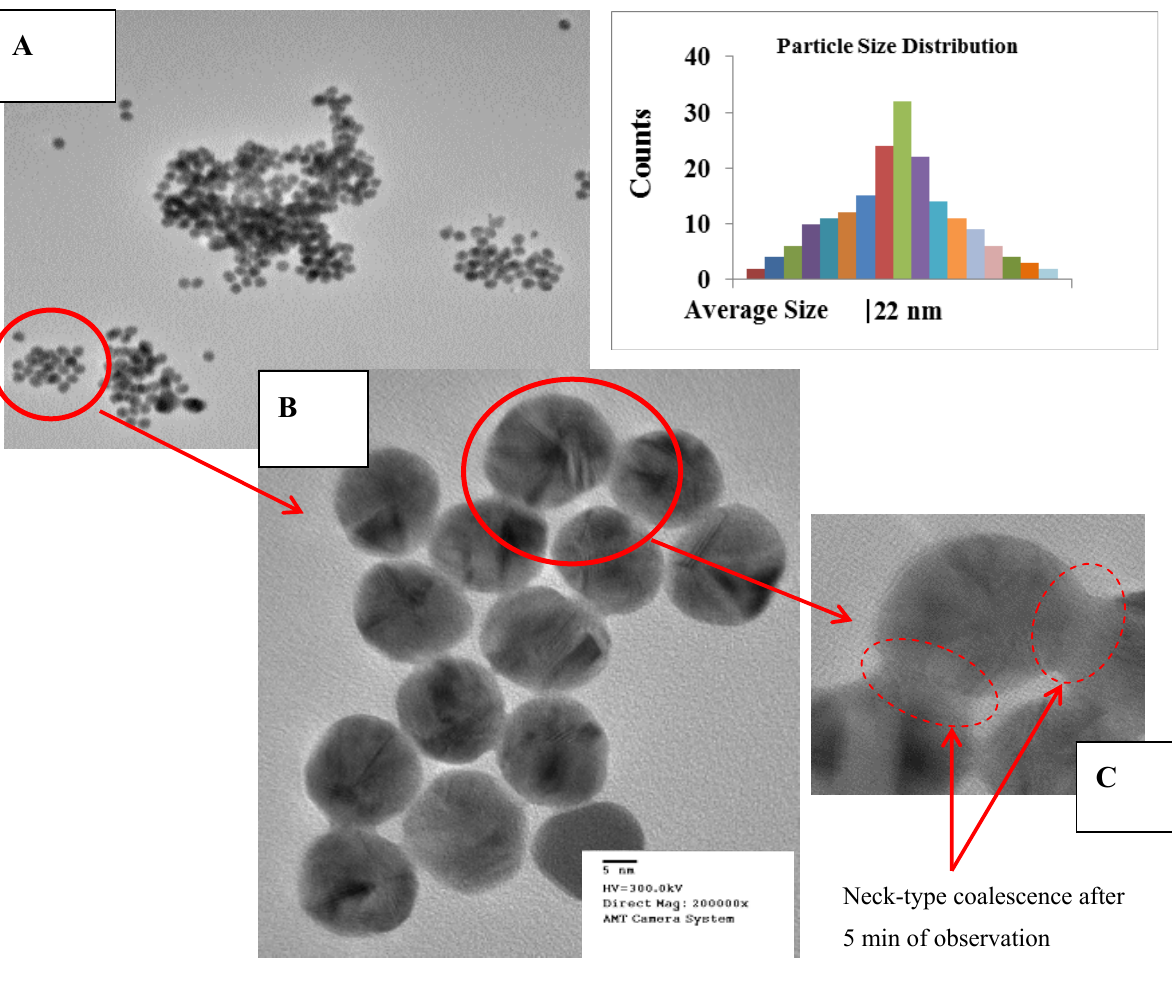
Figure 1. ( a ) HRTEM image indicating the agglomeration of Au-NP. ( b ) 5 nm of resolution HRTEM image on Au-NP six-fold symmetry is observed. ( c ) Coalescence